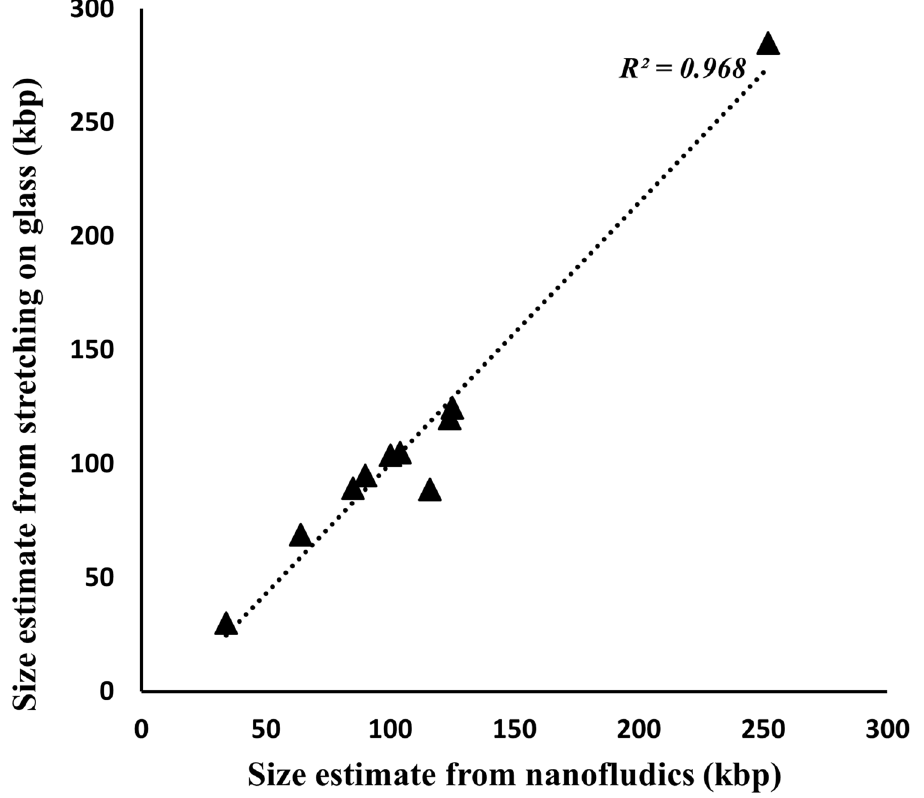
Figure 5. Size estimate comparison between DNA stretching on glass and in nanochannels for ten plasmids, ranging in size from 30 to 250 kbp, plotted and fitted with a straight